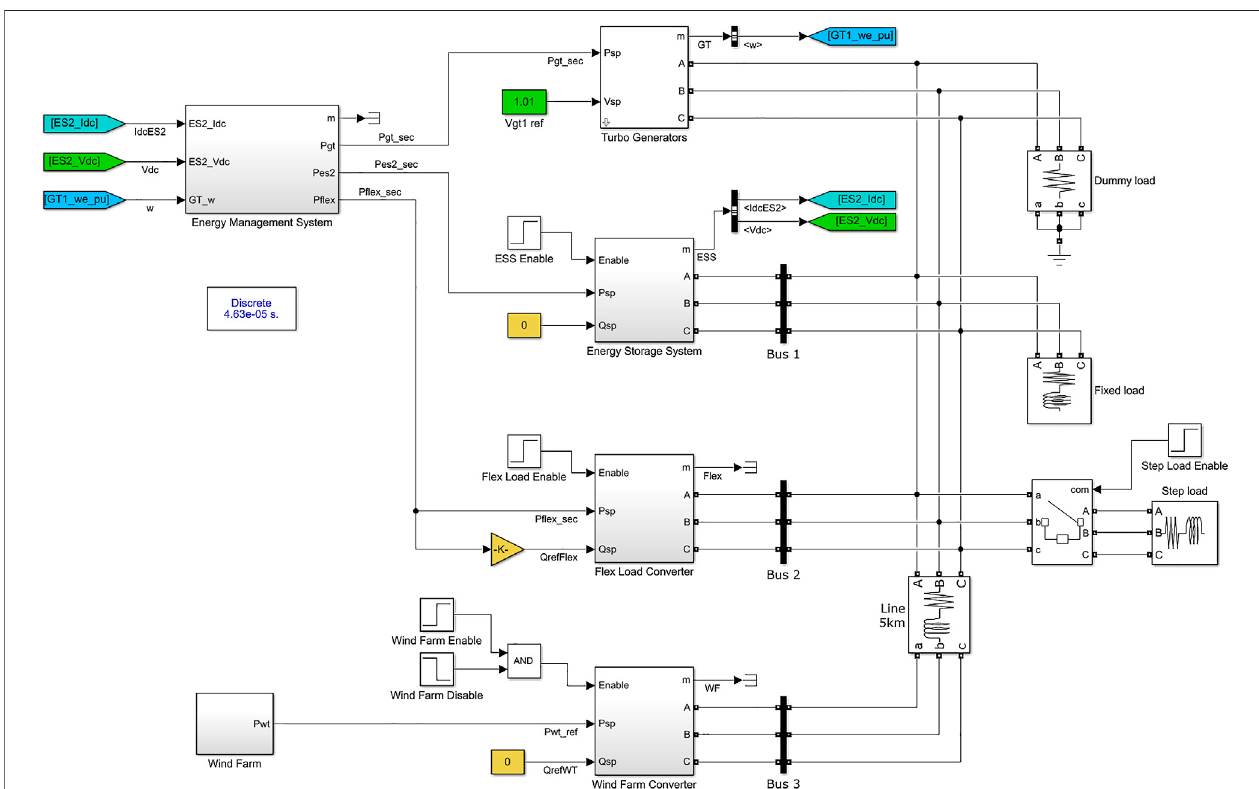
FIGURE 7 | Overview of the MATLAB Simulink model used to validate the proposed sizing of the energy storage device responsible for primary control in the case study.